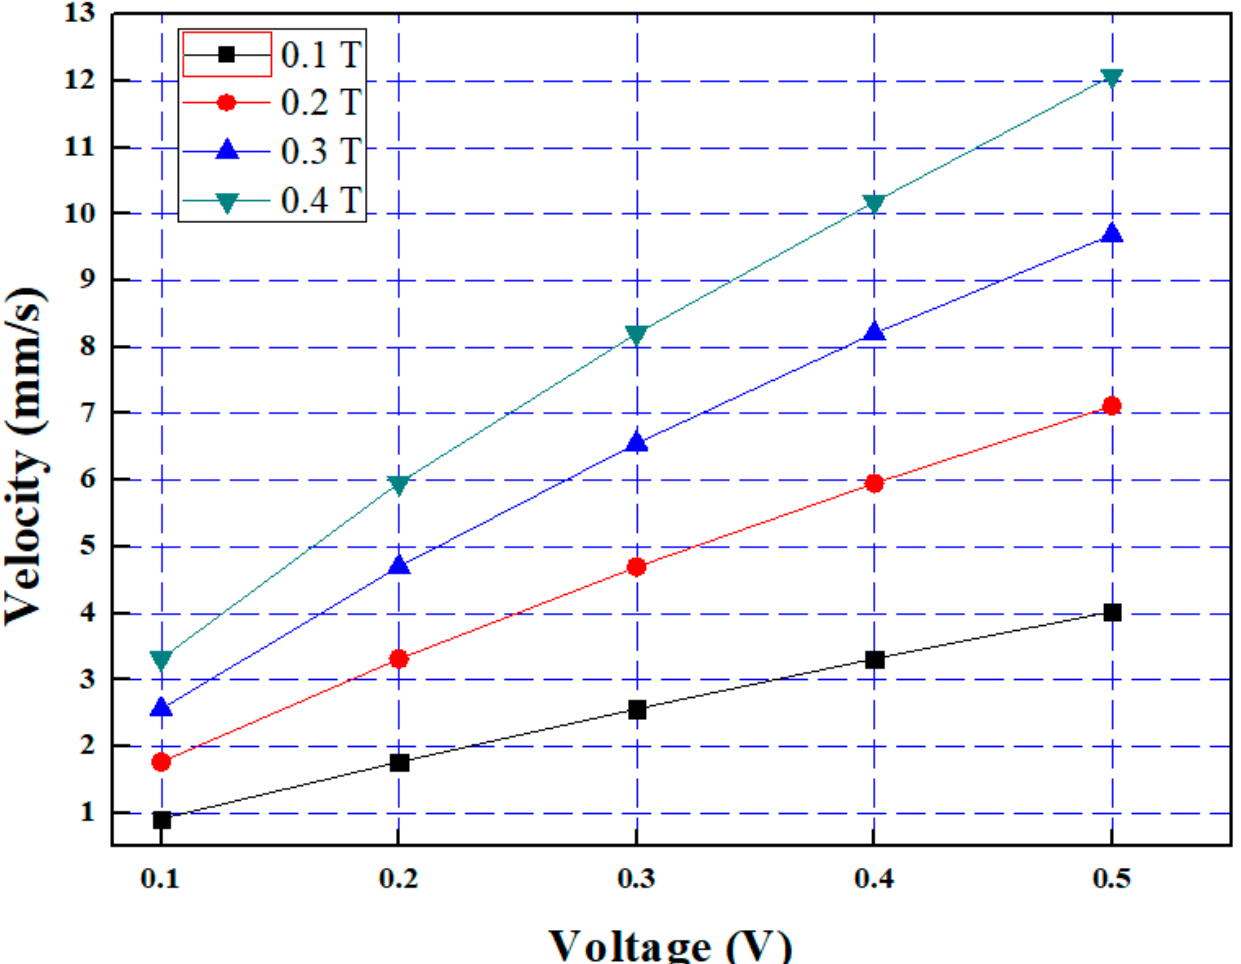
Figure 10. Velocity in cooling channel under various conditions of magnetic field intensity and volt- age.